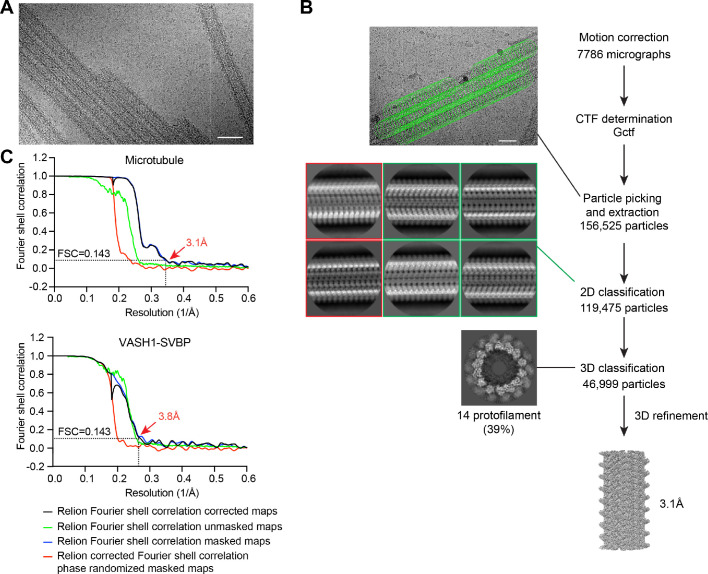
Structure determination of VASH1-SVBP-decorated GMPCPP-microtubules.(A) A representative micrograph of VASH1-SVBP-decorated GMPCPP-microtubules. Scale bar, 50 nm. (B) Processing workflow for cryo-EM structure determination of VASH1-SVBP-decorated GMPCPP-microtubules. The 2D classes of poorly decorated microtubules (red outlines) were discarded whereas the classes belonging to efficiently decorated microtubules (green outlines) were selected for subsequent 3D classification. (C) Fourier shell correlation (FSC) curves of GMPCPP-microtubules decorated with VASH1-SVBP. The FSC curves of microtubules (top) and VASH1-SVBP (bottom) were calculated separately. The final resolution for the reconstruction was estimated by calculating the Fourier shell correlation (FSC) of a single tubulin heterodimer in a ‘good’ protofilament after pseudo-helical averaging, using the FSC = 0.143 criterion.